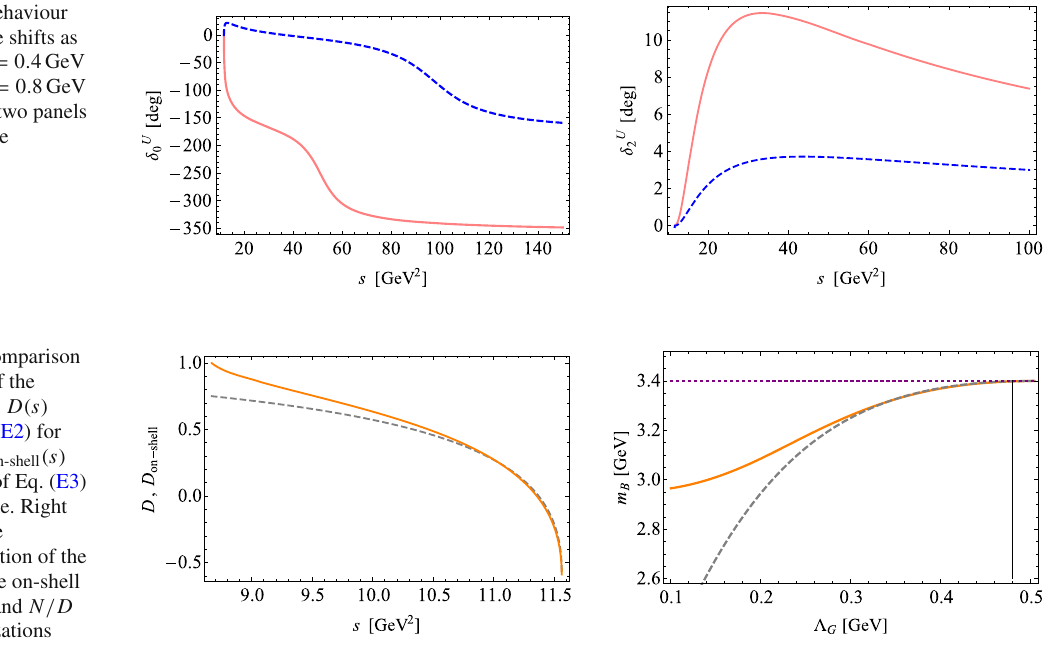
Fig. 8 Asymptotic behaviour of the unitarized phase shifts as function of s for (cid:2) G = 0 . 4GeV (pink, solid) and (cid:2) G = 0 . 8GeV (blue, dashed). In the two panels we show the S - and the D -waves